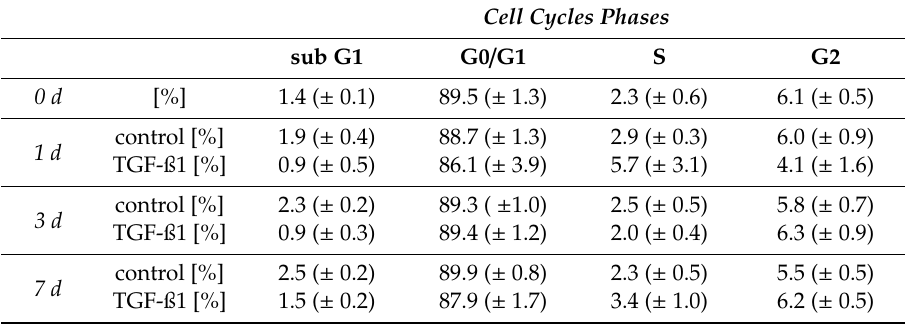
Table 1. Cell cycle analysis after the addition of 10 ng TGF-ß1 / ml compared with the control cultures. Data depicted as mean with the standard error of the mean (SEM) as percentage of all cells. Since the dataset did not represent a Gaussian distribution (Shapiro-Wilk test), the statistical analysis was performed using the Two-Way ANOVA test followed by Dunnett’s multiple comparison post hoc test ( n = 4). * p ≤